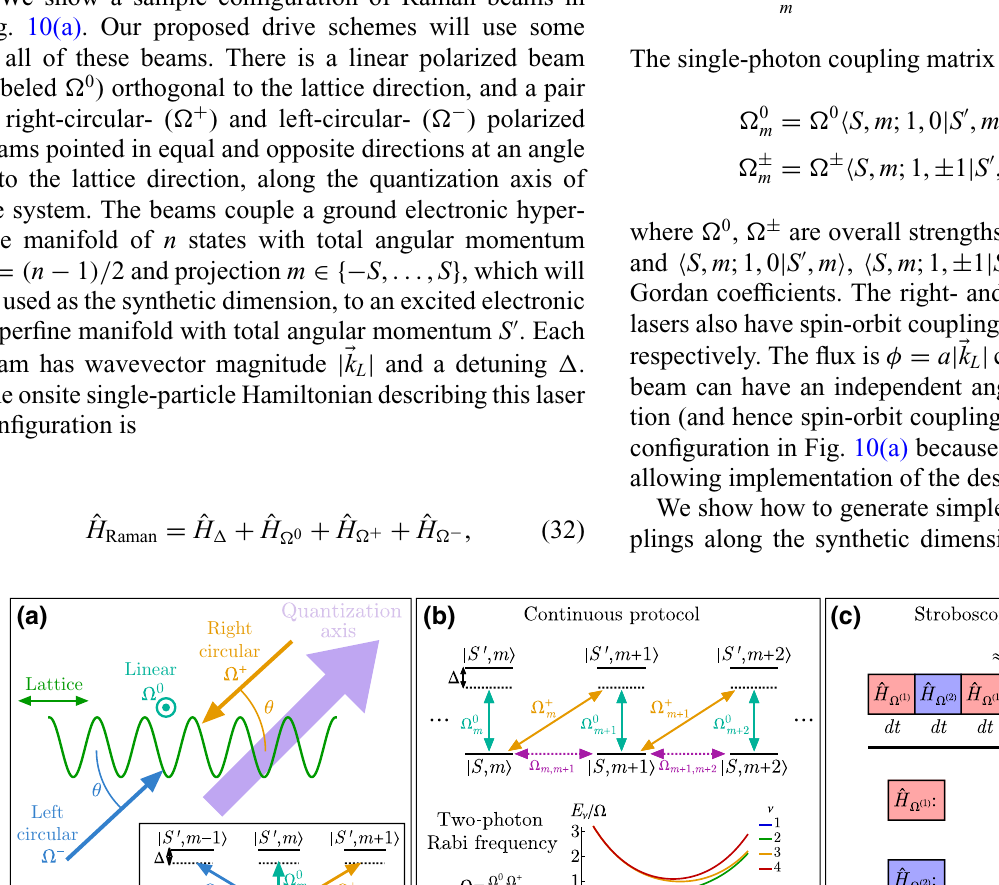
, (cid:2) ± are all m dependent due to m m ˆ S x -type coupling. Two different laser configurations ˆ H (cid:2) ( 1 ) and ˆ H (cid:2) ( 2 ) are ˆ ˆ ˆ ˆ S x ) 2 + S x , respectively, yielding the desired S x provided the S x ) 2 and − (